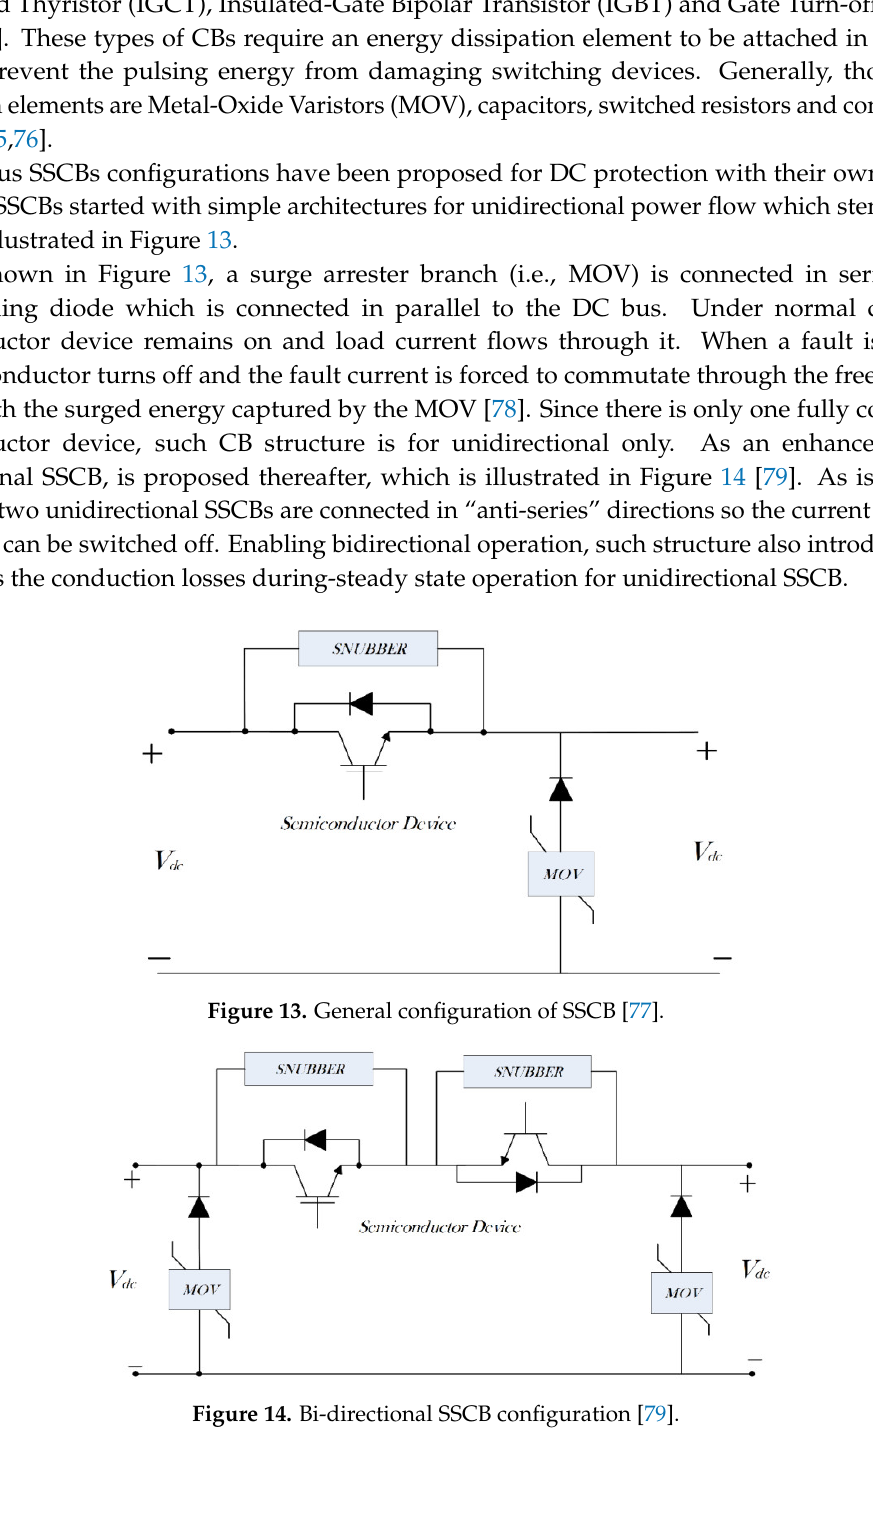
Figure 14. Bi-directional SSCB configuration [81].